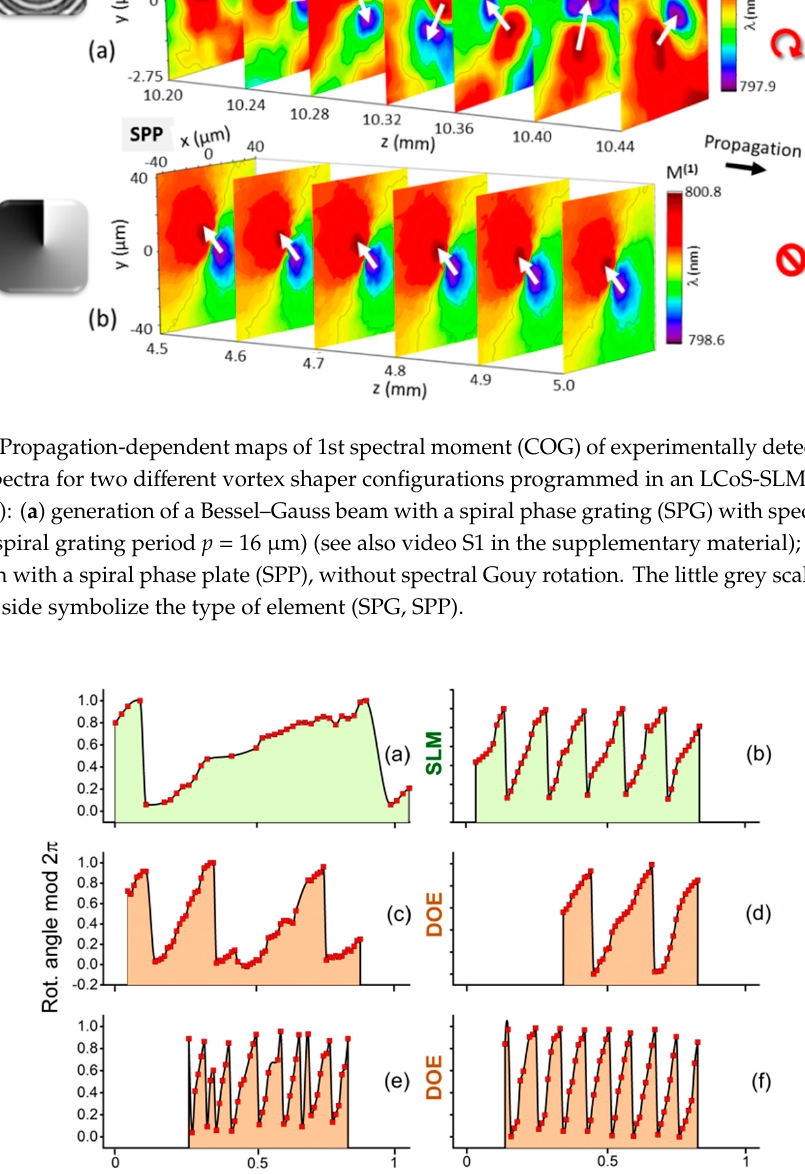
Figure 7. Controlling the angular velocity by varying geometrical parameters. The modulo of the rotation angle is plotted as a function of propagation distance for equal paths ∆ z . Di ff erent grating structure periods p and overall diameters D for programmable (SLM) and fixed (DOE) configurations are compared: ( a ) SLM, p = 32 µ m, D = 2 mm; ( b ) SLM, p = 16 µ m, D = 2 mm; ( c ) DOE, p = 32 µ m, D = 0.4 mm; ( d ) DOE, p = 16 µ m, D = 2 mm; ( e ) DOE, p = 16 µ m, D = 0.2 mm; and ( f ) DOE, p = 16 µ m, D = 0.4 mm.